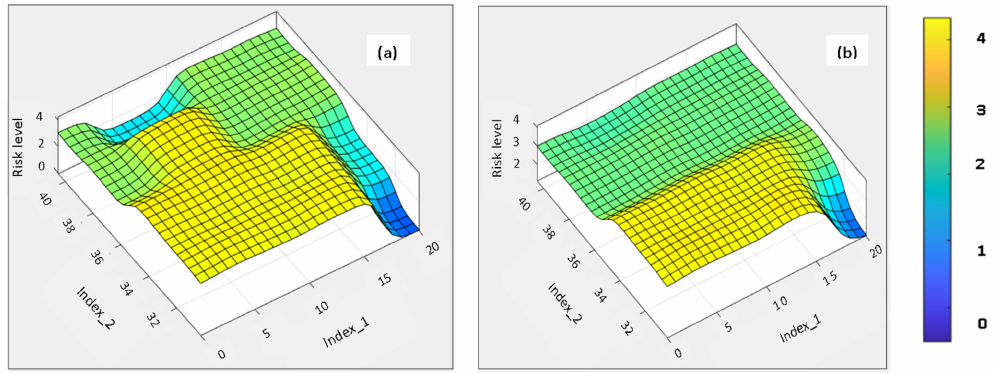
Figure 16. Example of the 3D surface plots of the rule base system adapted for the data for di ff erent mf types; ( a ) dsigmf, ( b )